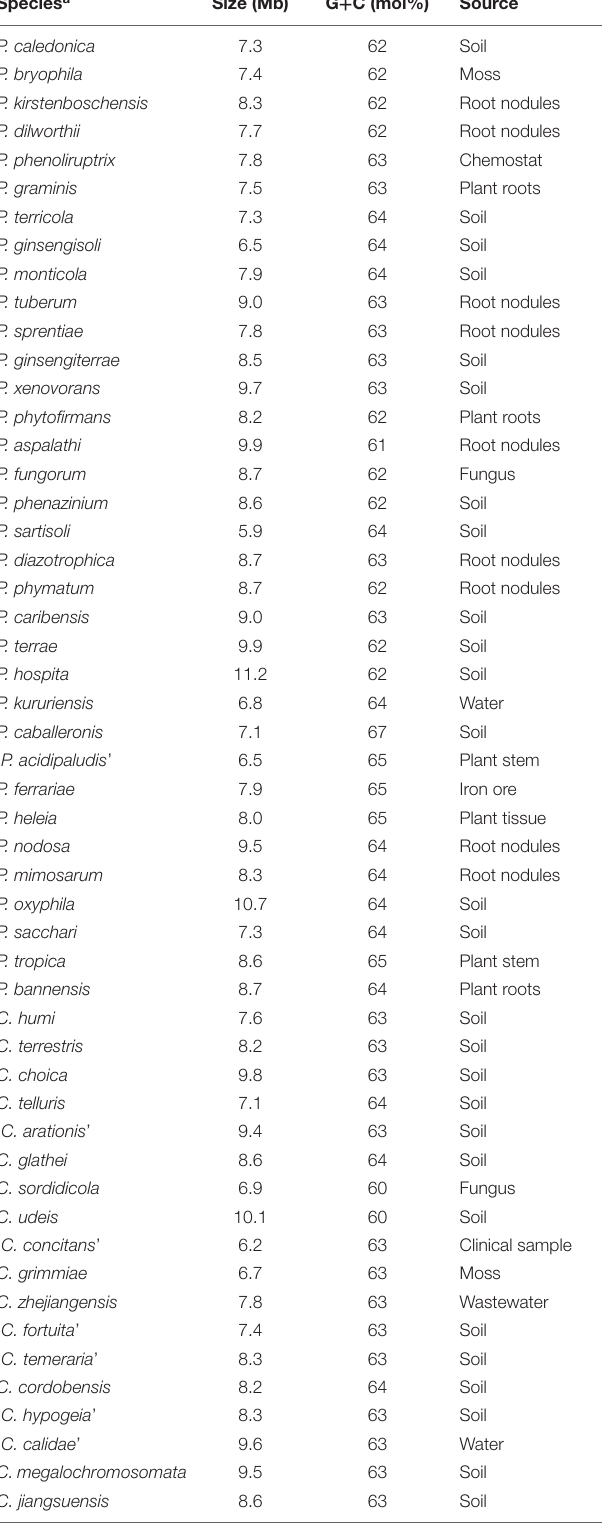
TABLE 2 | Genome properties for all the investigated species forming part of Burkholderia sensu stricto, Caballeronia and Paraburkholderia . Species a Size (Mb) G + C (mol%)